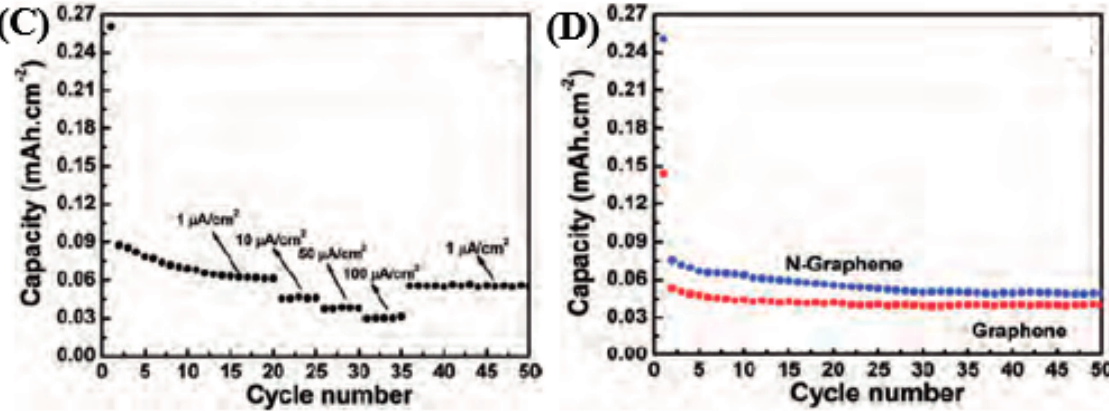
Figure 6. ( A ) HRTEM image of three-layered N-doped grapheme. ( B ) Charge-discharge voltage profiles for the N-doped graphene electrode cycled at a rate of 5 μ A·cm − 2 between 3.2 and 0.02 V vs. Li/Li + . ( C ) Rate capability studies of N-doped graphene films: discharge capacity vs. cycle number at various current rates (1, 10, 50, and 100 μ A·cm − 2 ). ( D ) Cycling stability for the pristine graphene and N-doped graphene cycled at a rate of 5 μ A·cm − 2 between 3.2 and 0.02 V vs. Li/Li + . Reproduced from [121] with permission